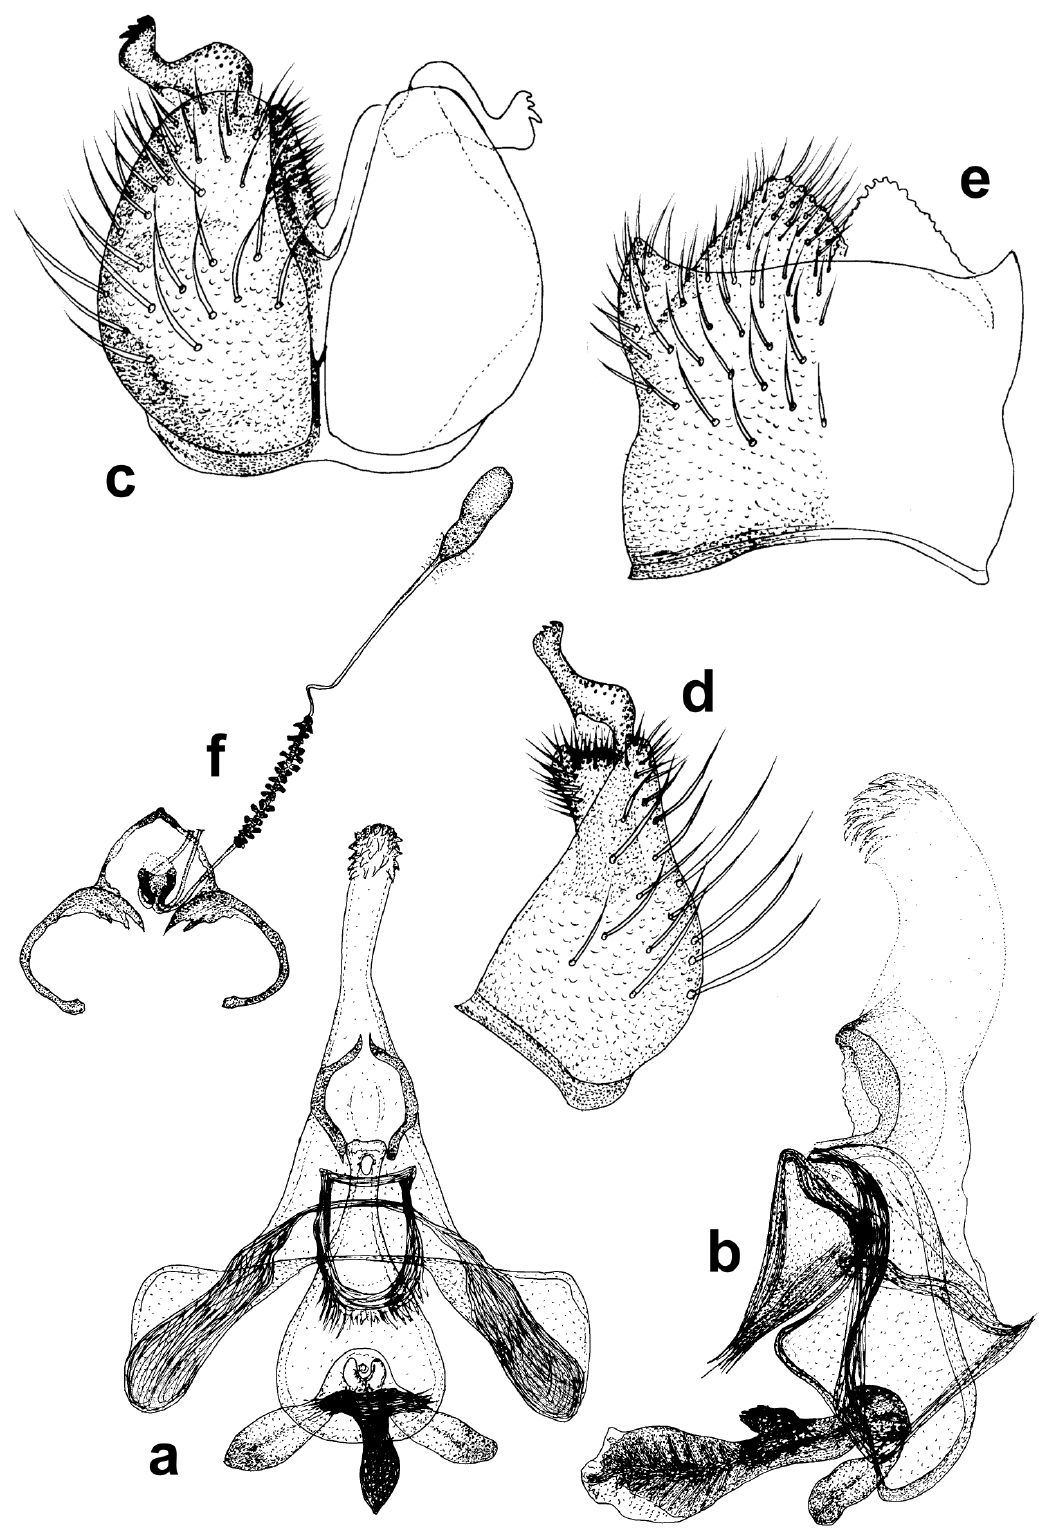
Fig. 48. Protypusia hyalipennis (Séguy, 1941) gen. et comb. nov. a . Epiphallic complex ventral. b . Epiphallic complex lateral. c . Gonocoxite ventral. d . Gonocoxite lateral. e . Epandrium dorsal. f . Female genitalia